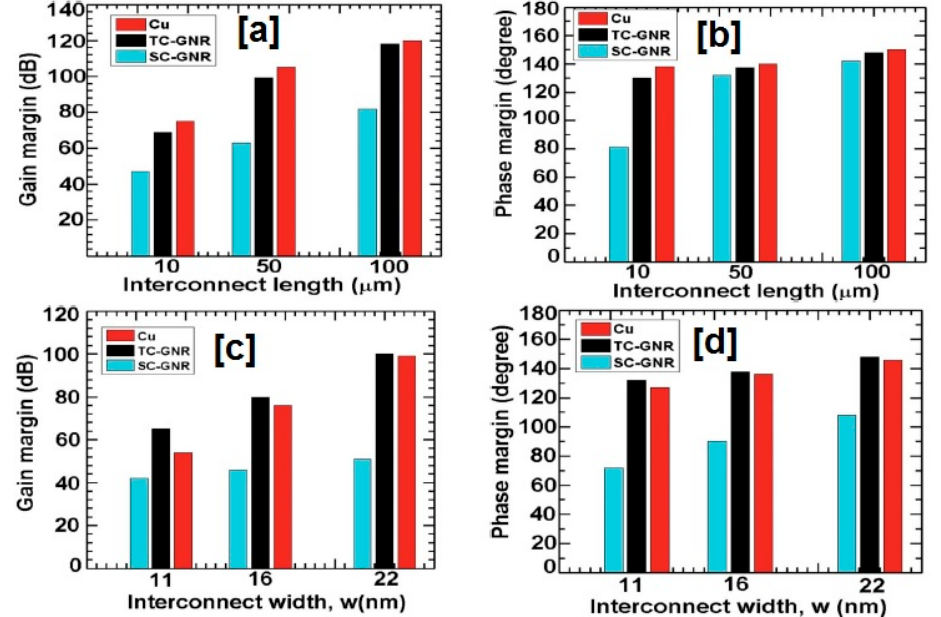
Figure 24. Bode stability analysis for Cu, TC-GNR, and SC-GNR interconnects. ( a ) Gain margin (dB) and ( b ) phase margin (degree) vs. interconnect length plot of at 16 nm technology node; ( c ) Gain margin (dB) and ( d ) phase margin (degree) vs. interconnect width ( w ) plot at 10 µm length [63]. Reproduced with permission from [63]. IEEE, 2017.